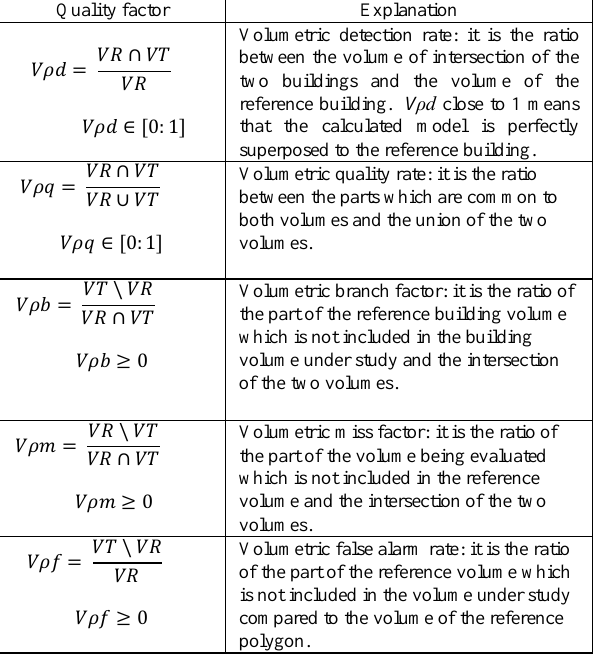
Table 10. Volumetric quality factors for assessing 3D building